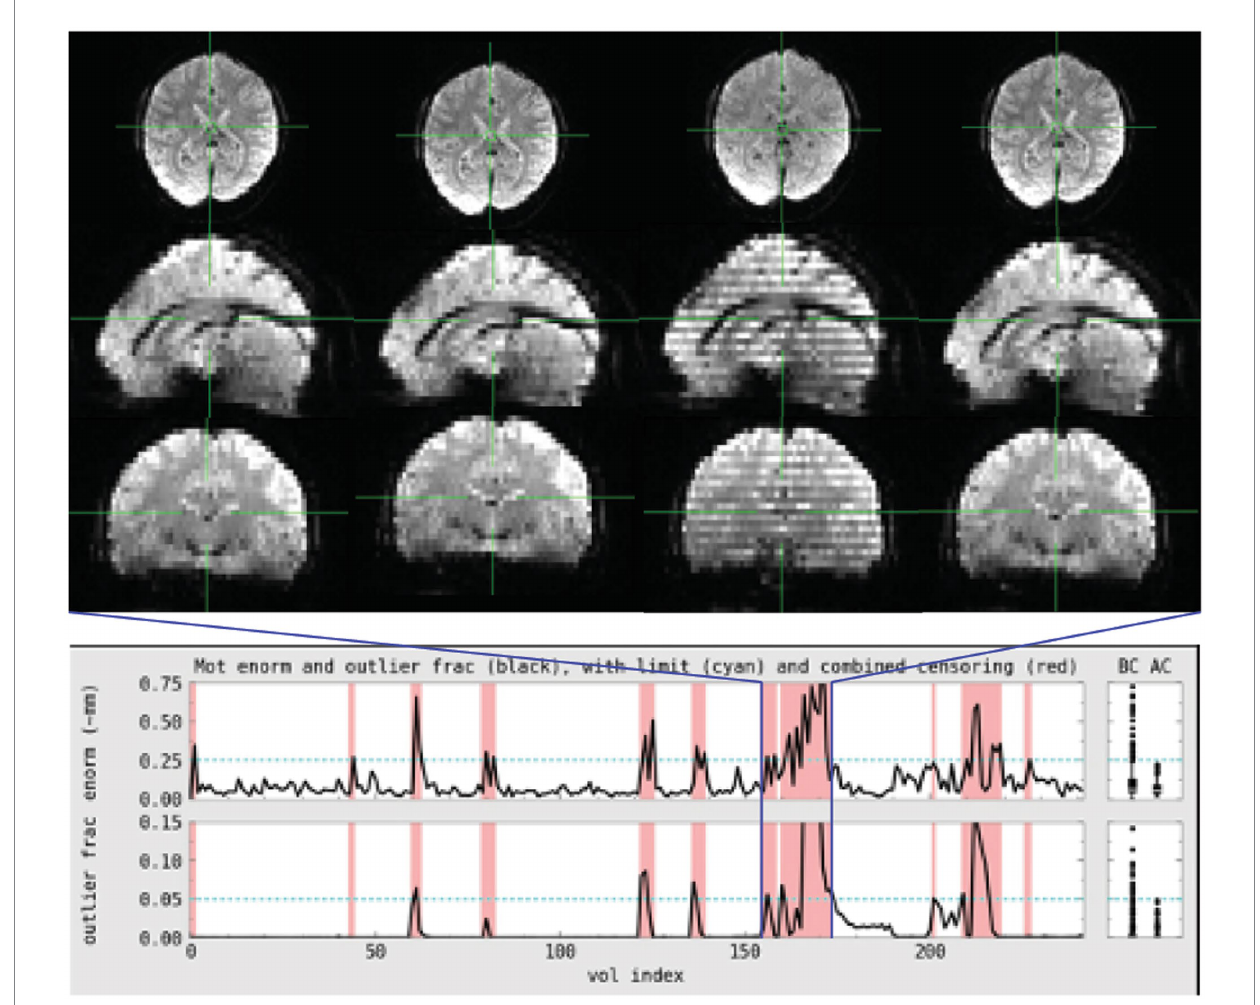
FIGURE 2 Subject 029 had a more subtle motion artifact than depicted for subject 017. The banding is visible during the period with the most motion but is otherwise more subtle and would be less likely to be noticed during acquisition without automated QC